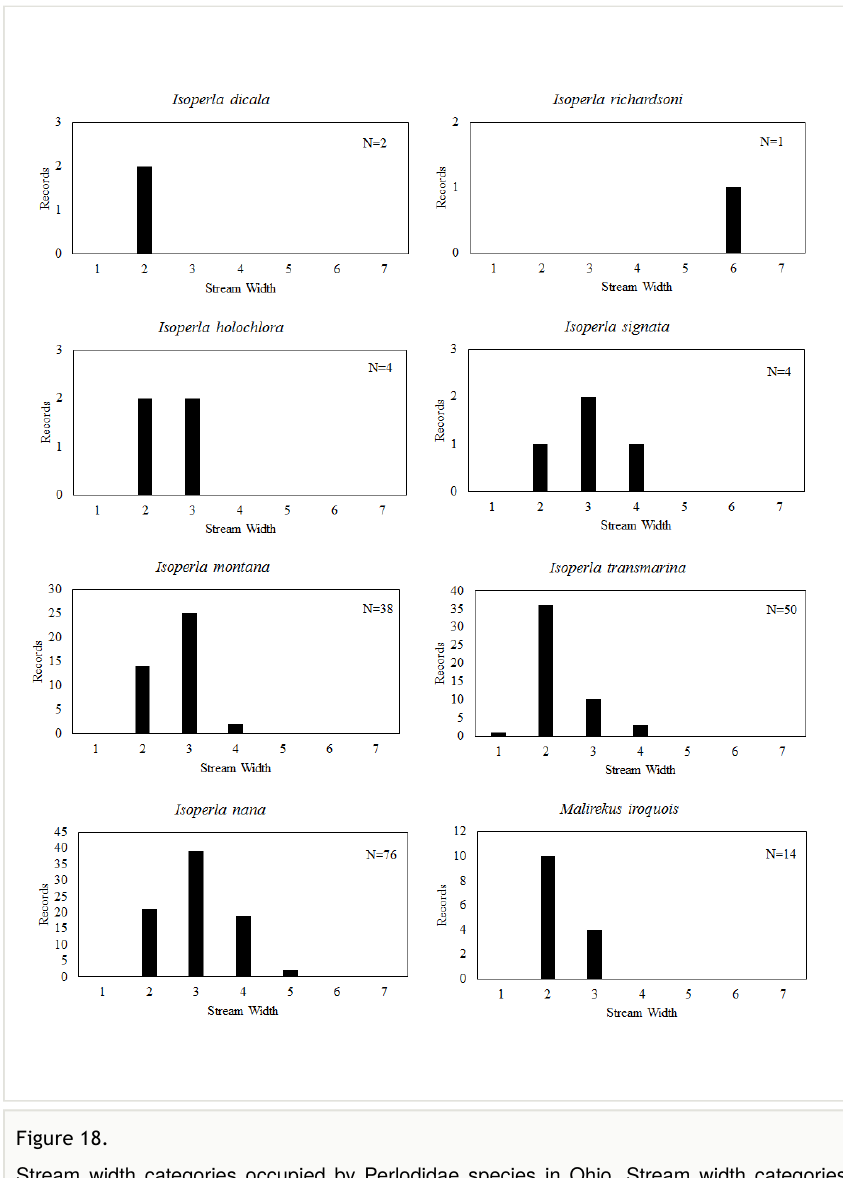
Figure 18. Stream width categories occupied by Perlodidae species in Ohio. Stream width categories: 1=seep, 2=1-2 m, 3=3-10 m, 4=11=30 m, 5=31-60 m, 6=>60 m, 7=Lake